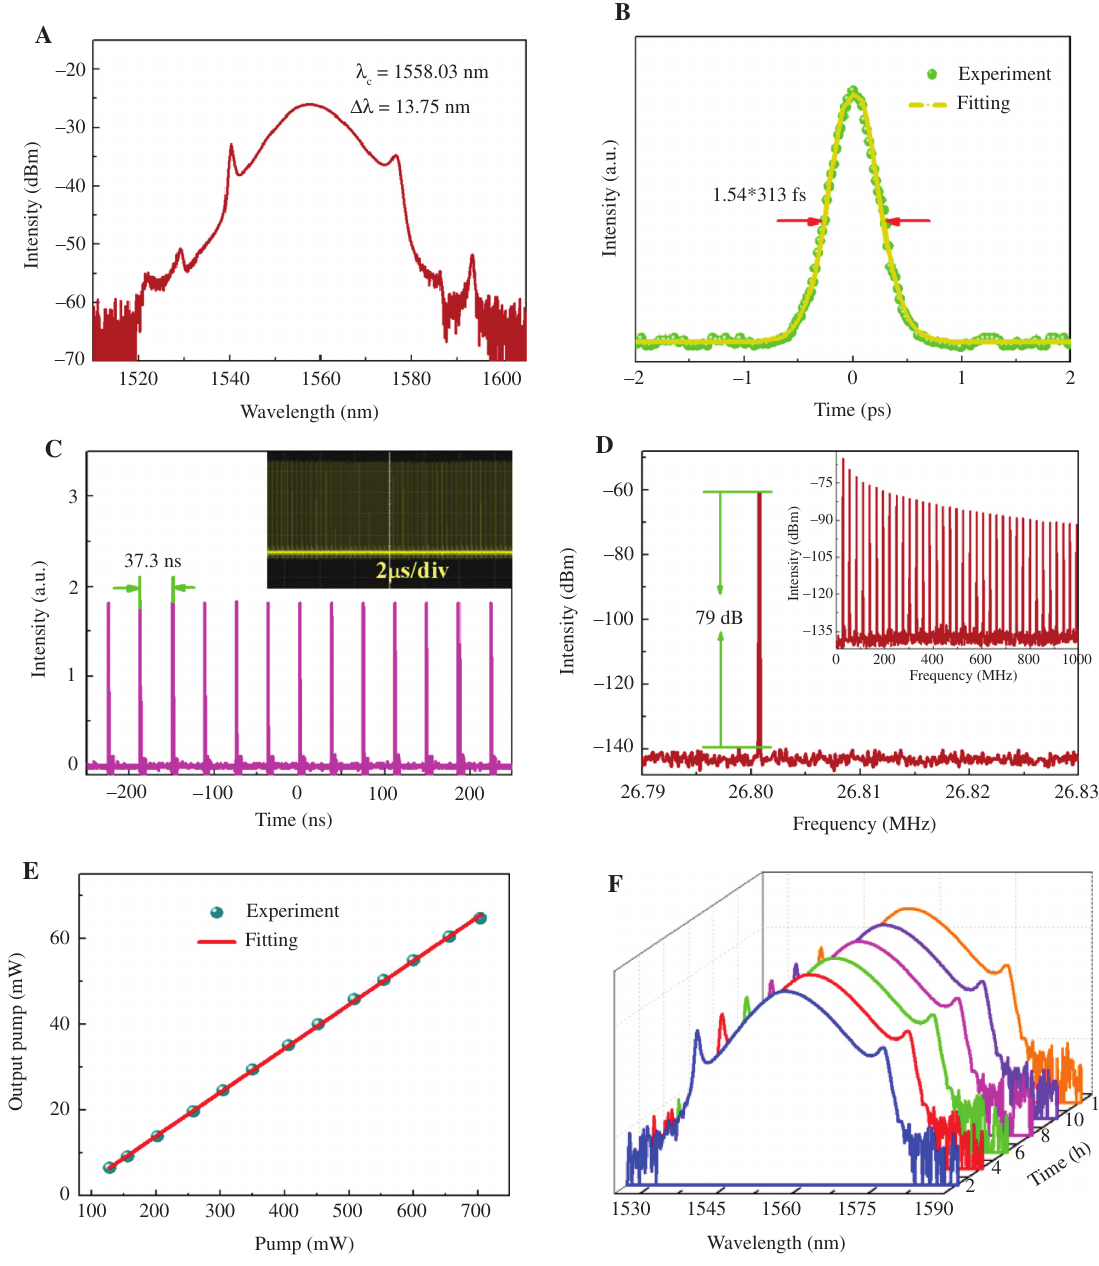
Figure 4: Typical mode-locked fiber laser characteristics. (A) Typical mode-locked optical spectrum. (B) The corresponding autocorrelation trace. (C) Pulse trains of oscilloscope. (D) Radiofrequency spectrum. (E) Relationship between output power and pump power. (F) The output spectra measured every 2 h showing long-term stability of the mode-locking